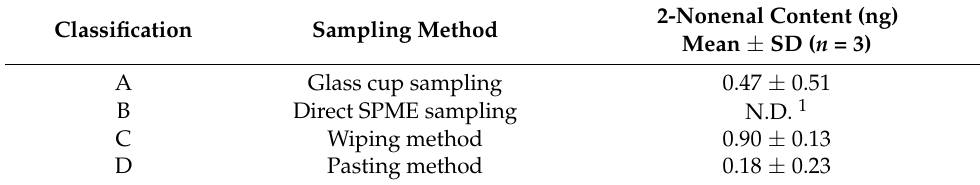
Table 1. Comparison of skin emission sampling